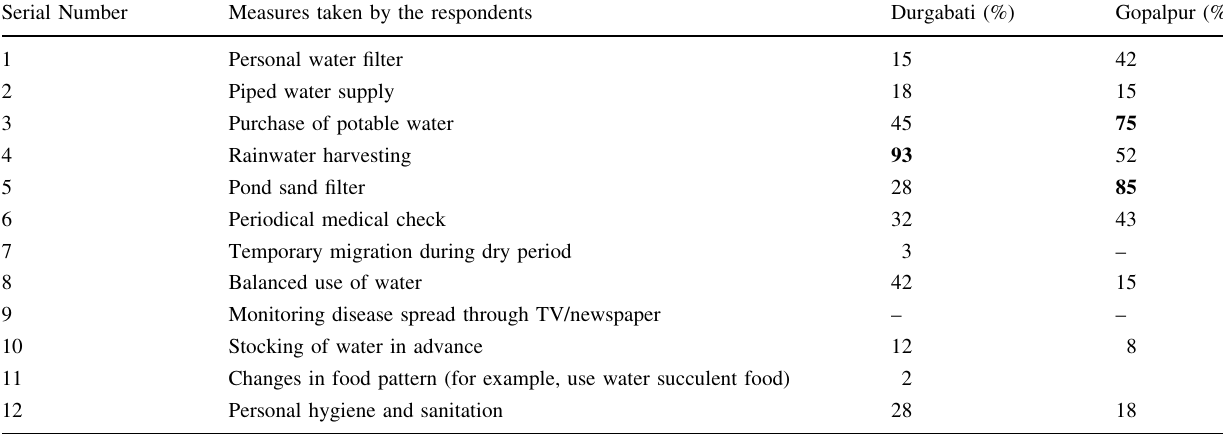
Table 2 Suitable measures against water scarcity and health problems in the two study villages of southwestern coastal